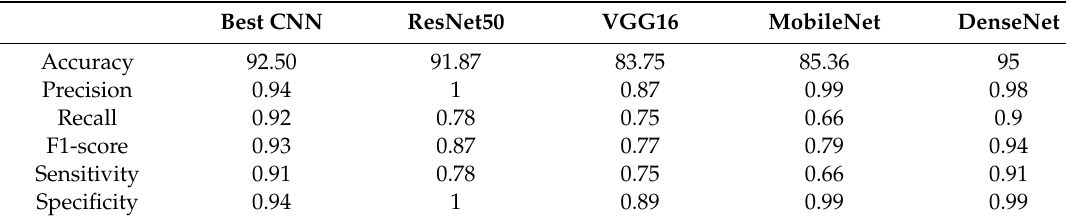
Table 13. Benign class performance comparison of di ff erent